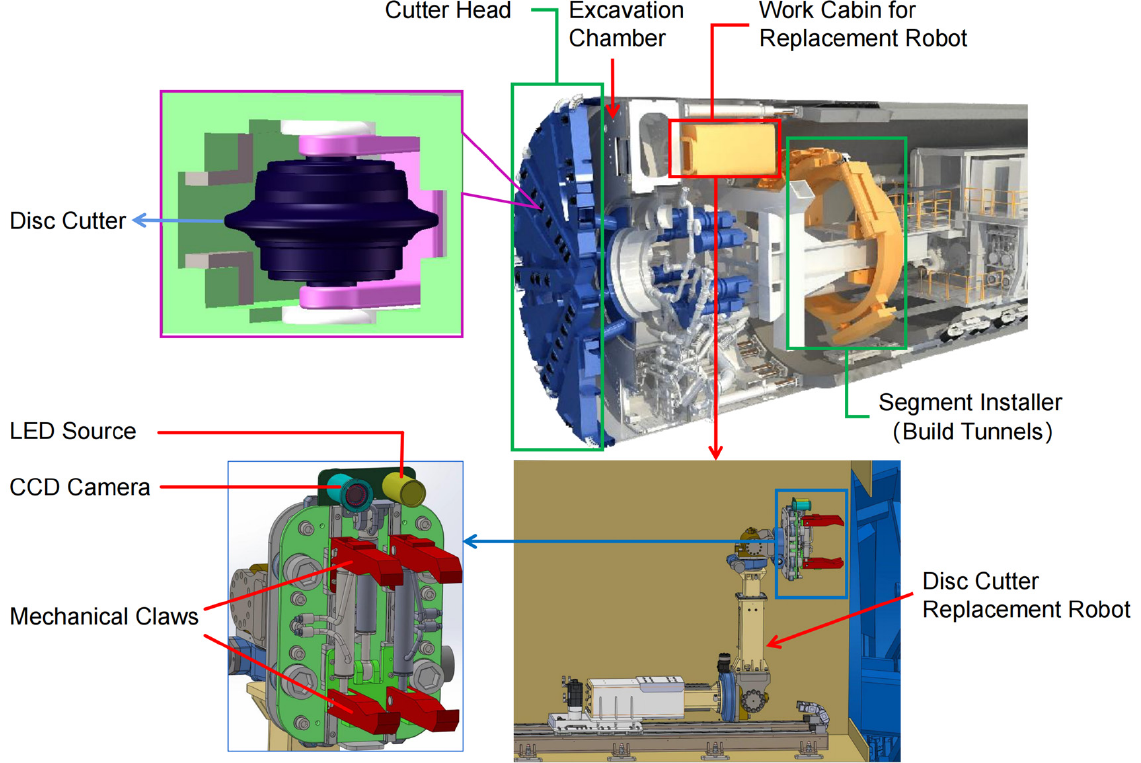
Figure 1. Schematic diagram of the disc cutter replacement robot.